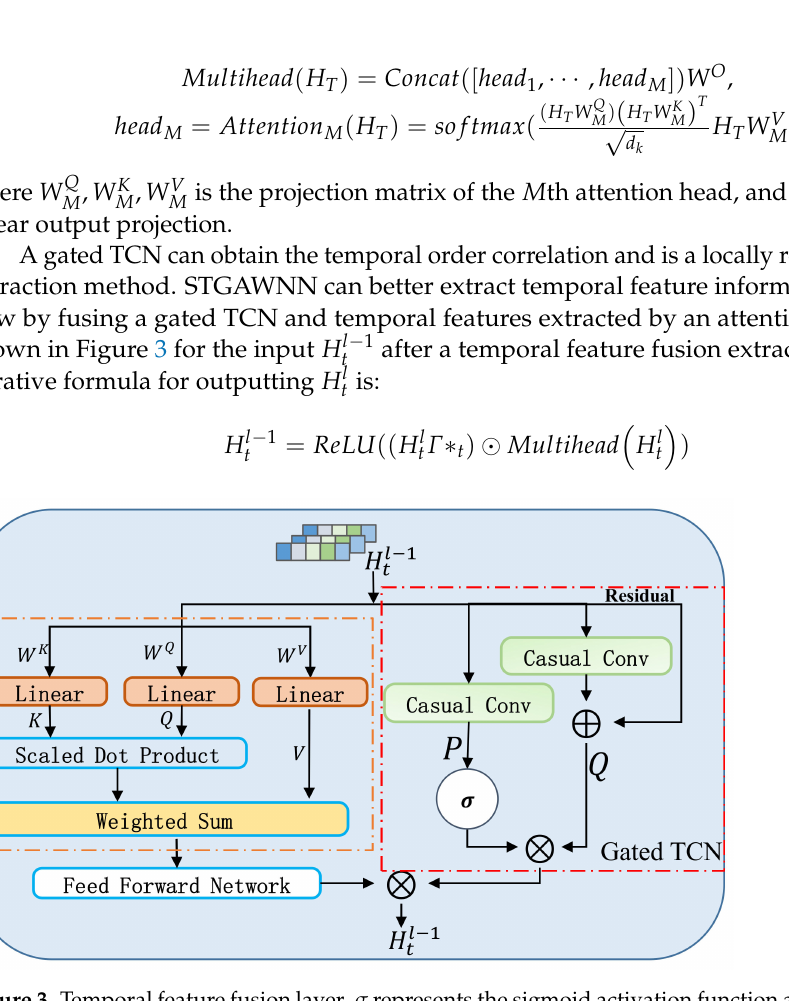
Figure 3. Temporal feature fusion layer. σ represents the sigmoid activation function and ⊗ represents the element-wise Hadamard product between two branches. P and Q are the outputs of Casual